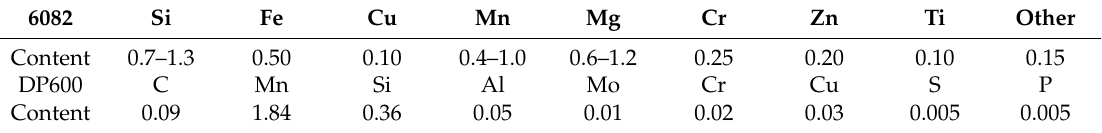
Table 1. The chemical composition of 6082 aluminum alloy and DP600 galvanized steel (in wt %).